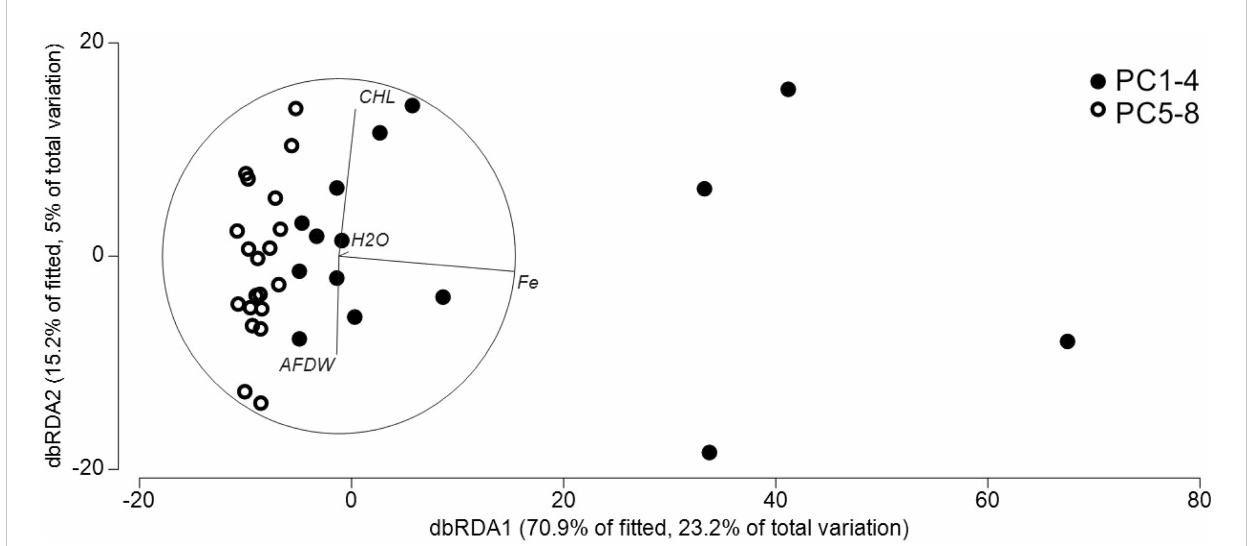
FIGURE 6 Distance-based redundancy analysis ordination to investigate relationship between the environmental variables and bacteria communities in ferrous and non-ferrous sediments. CHL: chlorophyll a ; AFDW: total organic matter measured as ash-free dry-weight of the sediments; H2O: sediment porosity indicated by the water content of the sediments.